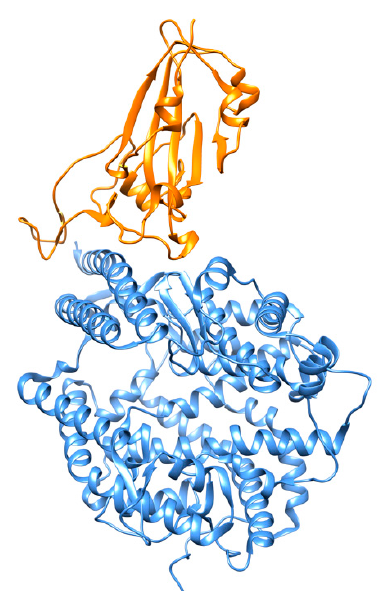
Figure 5. SARS-CoV-2 spike receptor-binding domain (in orange) bound to the ACE2 receptor (in cornflower blue) (PDB id 6m0j) [15].